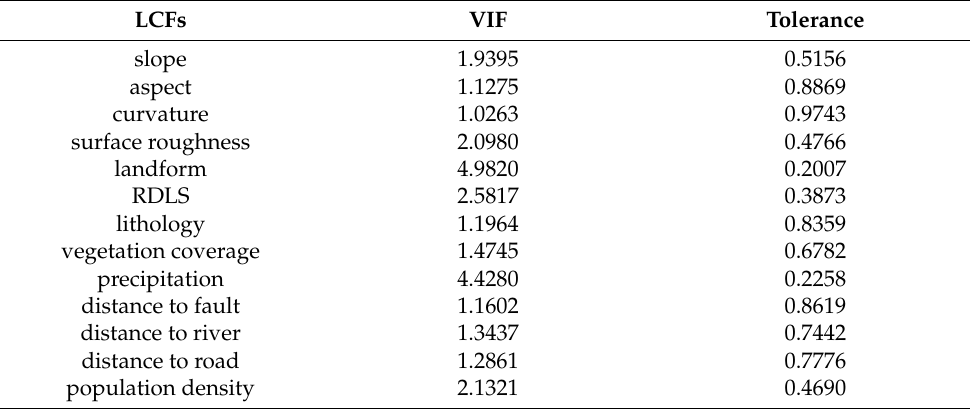
Table 3. Multicollinearity diagnosis for the 13 landslide condition factors